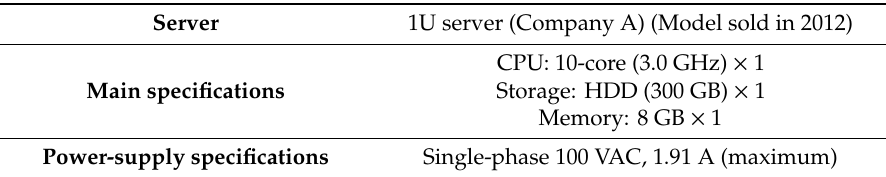
Table 3. Server specifications.